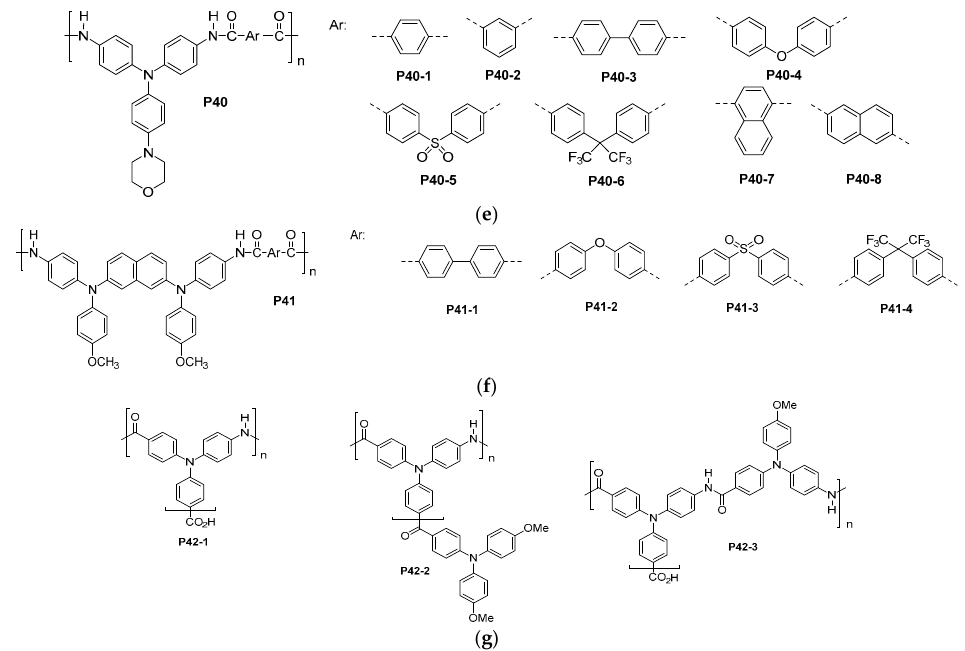
Table 3. Summary electroactive sub-groups in electrochromic